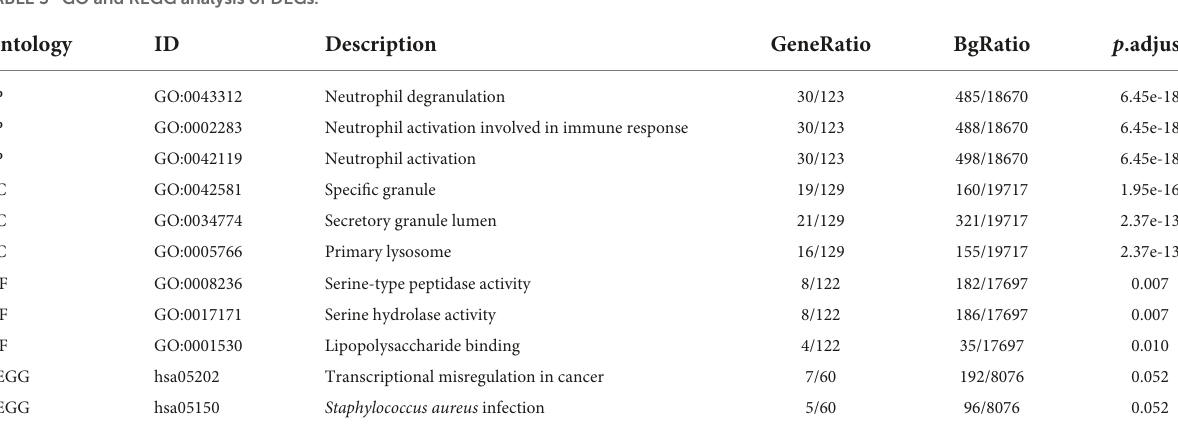
TABLE 3 GO and KEGG analysis of